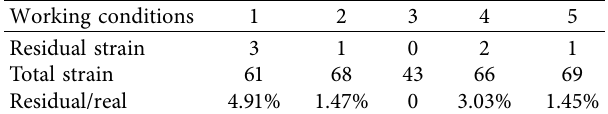
Table 3: Residual strain of the control section.